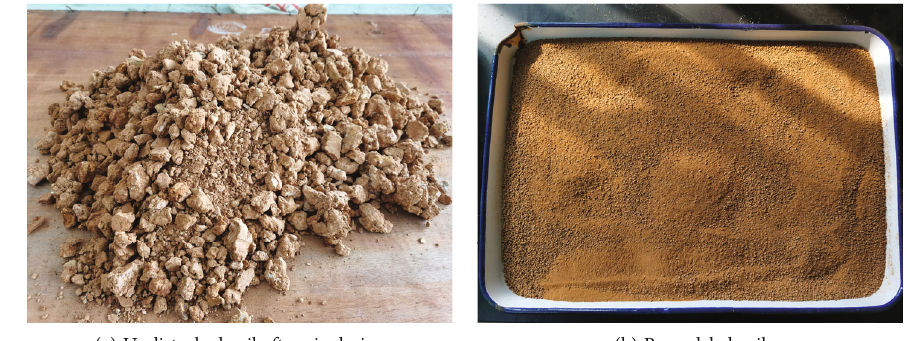
Figure 1: Crushed silty clay.